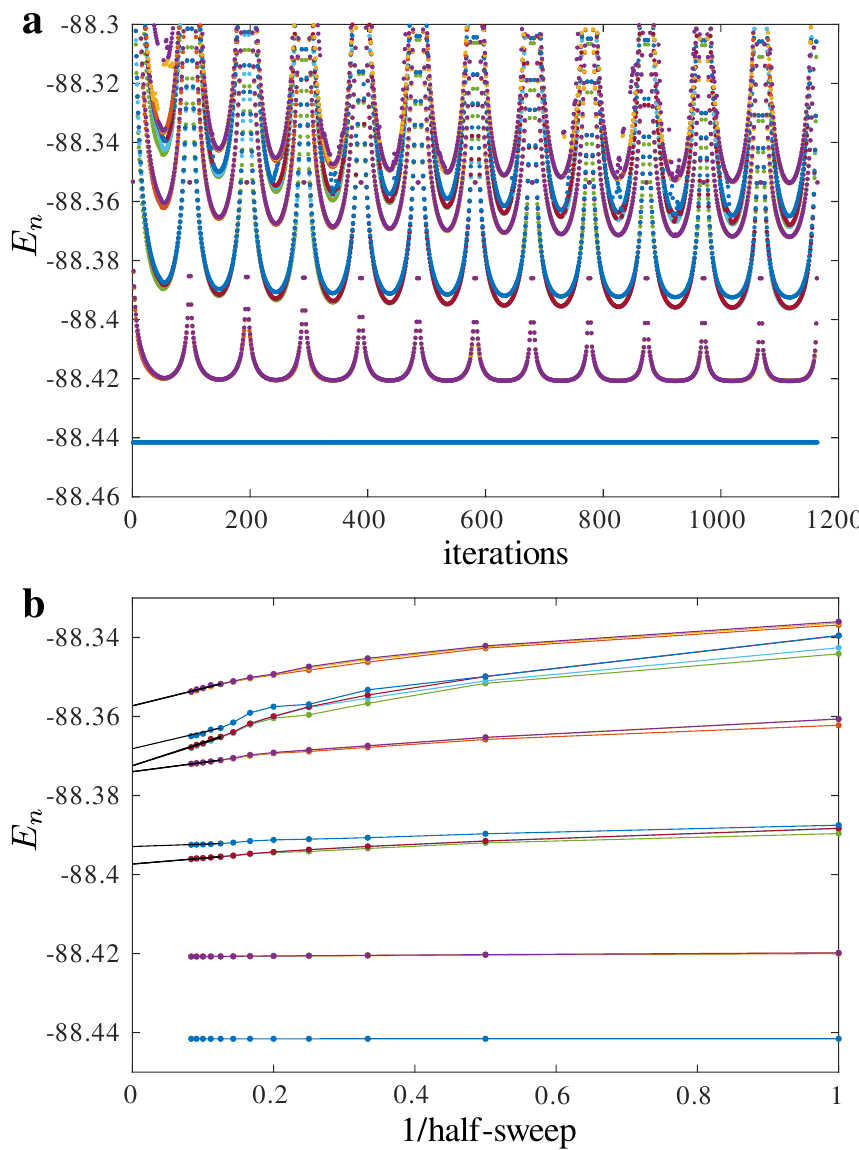
Figure 1: a Energy of the 19 low-energy states in the critical four-state Potts model with N = 100 sites as a function of iterations. The periodic increase of the energy oc- curs close to the chain boundary and is the result of the reduced Hilbert space by MPS construction. The flattening of the energies in the middle of the chain is an indicator of convergence. Non converged states are extrapolated towards infinite number of sweeps (equivalently infinite bond dimension) as shown in b . Note that many of the shown states are three-fold degenerate and some data points are completely hidden behind the